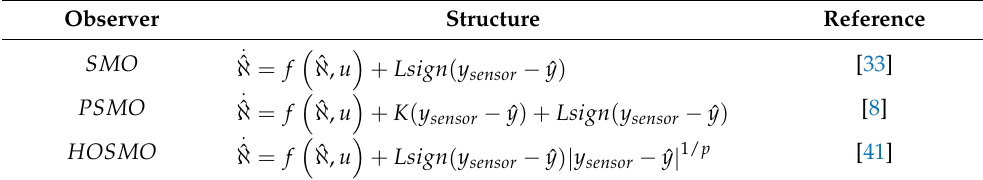
Table 4. Structures of state